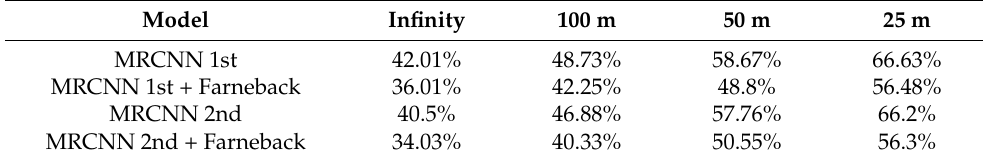
Table 4. Depth influence on AP 50, Cityscapes dataset [2].